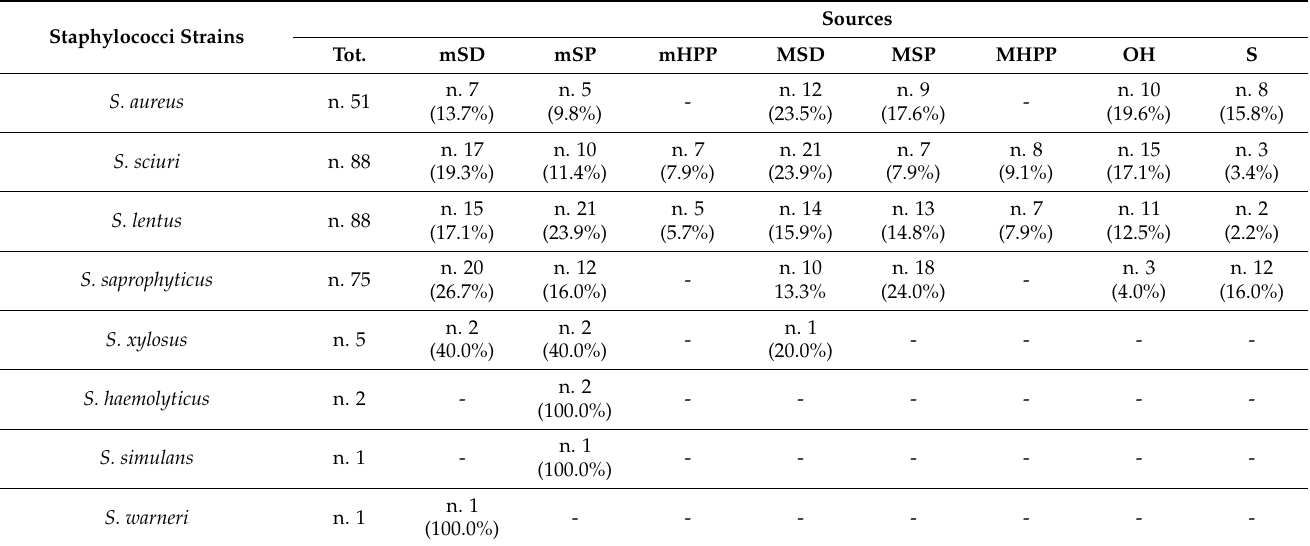
Table 4. Identified strains belonging to the Staphylococcus